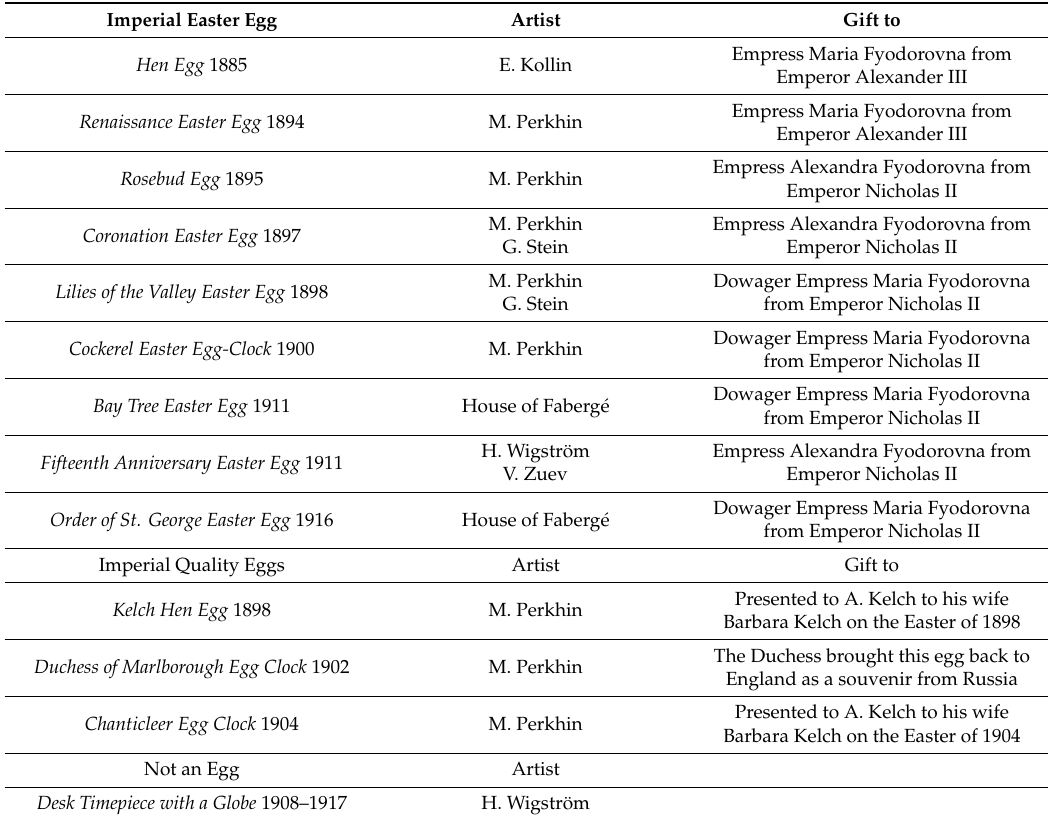
Table 3. Recorded Faberg é Eggs as OptoClones TM